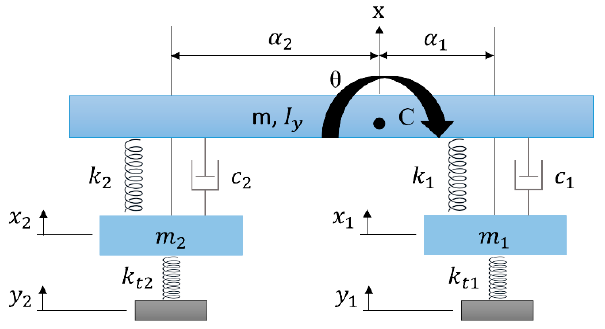
Figure 3. The 4-DOF half-car model adapted from Jazar [29].